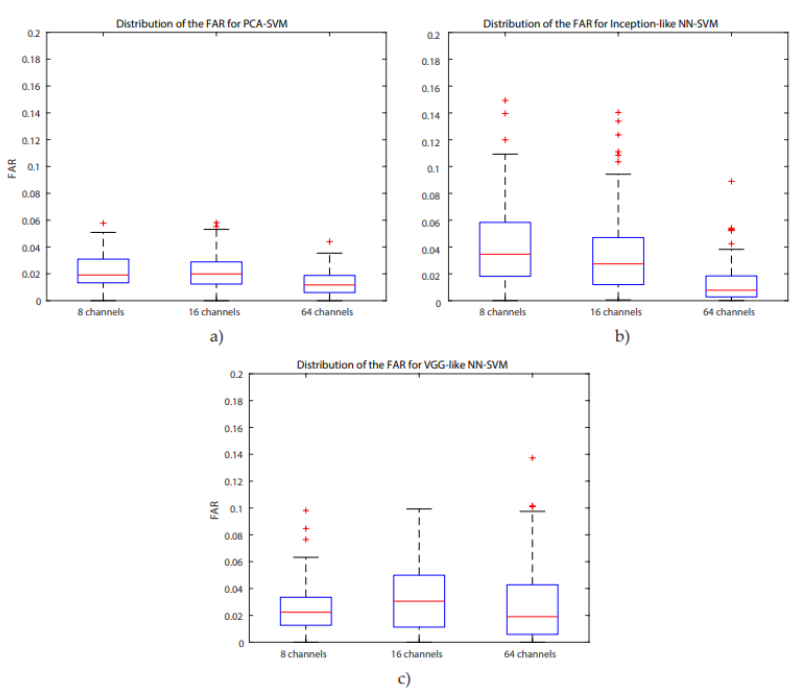
Figure 8. Distribution of FAR across subjects for 8, 16, and 64 channels for the ( a ) PCA ‐ SVM, ( b )